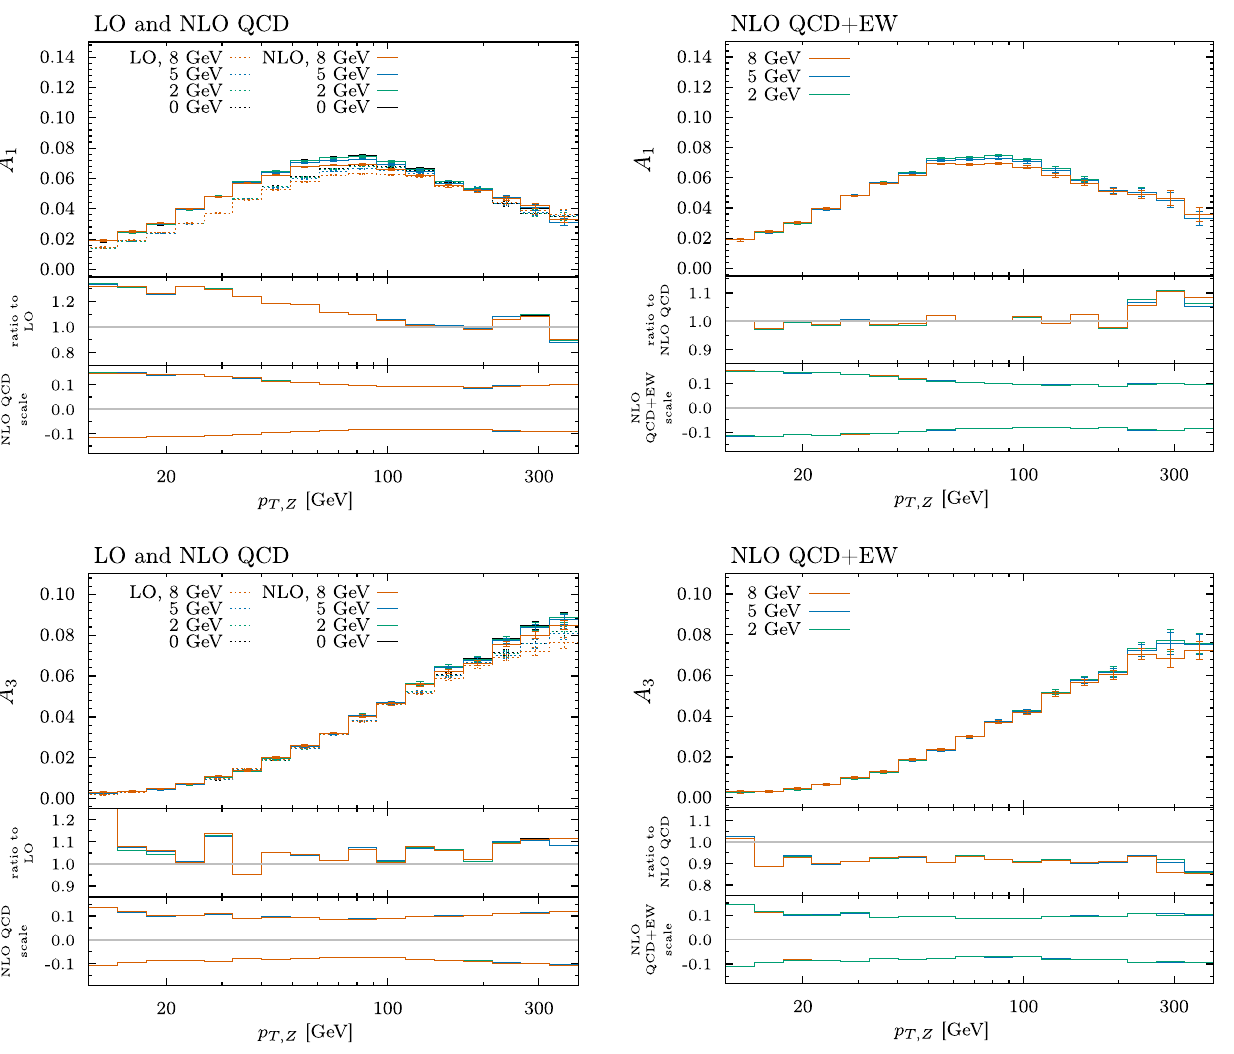
Fig. 3 The two angular coefficients A 1 (top) and A 3 (bottom), the LO and NLO QCD (left) and the NLO QCD + EW contribution (right) with corresponding ratios and scale uncertainties. The four (left) and three